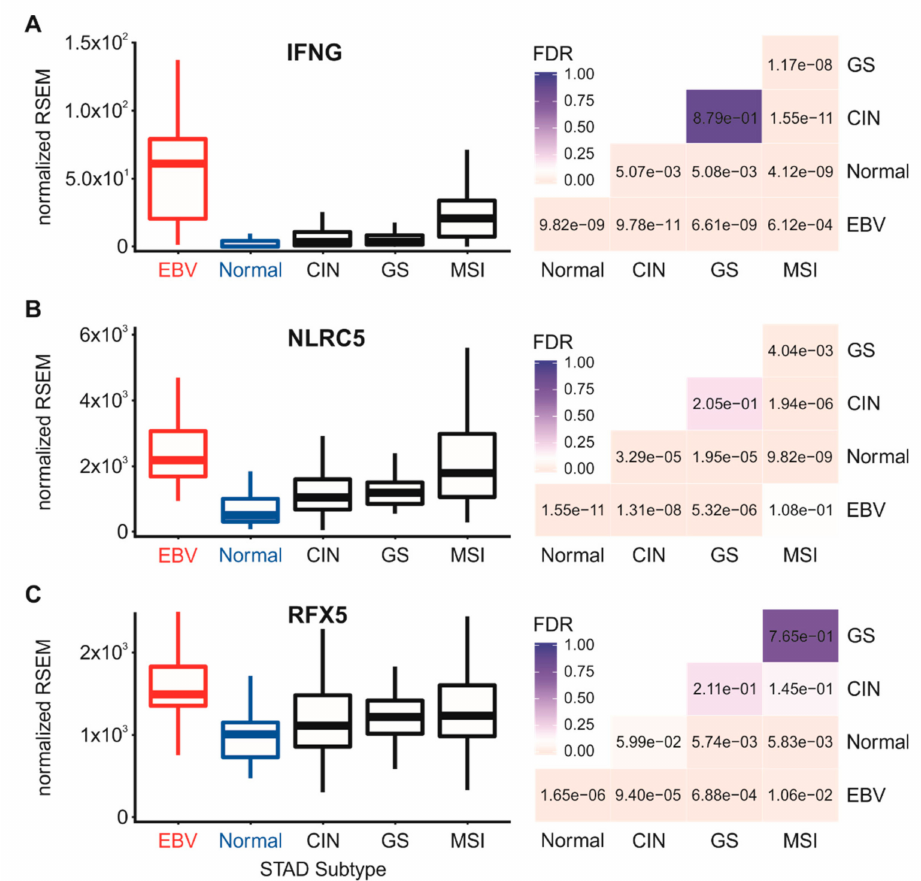
Figure 6. Expression of mRNA encoding IFN- γ and transcription factors involved in regulating the interferon-dependent activation of MHC-I-dependent antigen presentation and loading genes. Normalized RNA-seq data for the IFN- γ (IFNG) gene ( A ) and the genes encoding the nucleotide-binding oligomerization domain (NOD)-like receptor caspase recruitment domain containing protein 5 (NLRC5) / MHC-I transactivator (CITA; panel ( B )) and Regulatory Factor X5 (RFX5; panel ( C )) transcription factors involved in interferon-induced activation of expression of genes involved in MHC-I-dependent antigen presentation were extracted from the TCGA database for the STAD cohort for EBVaGCs, normal control tissues, and three other GC subtypes. FDR-adjusted p -values for each statistical comparison are shown on the right for each gene